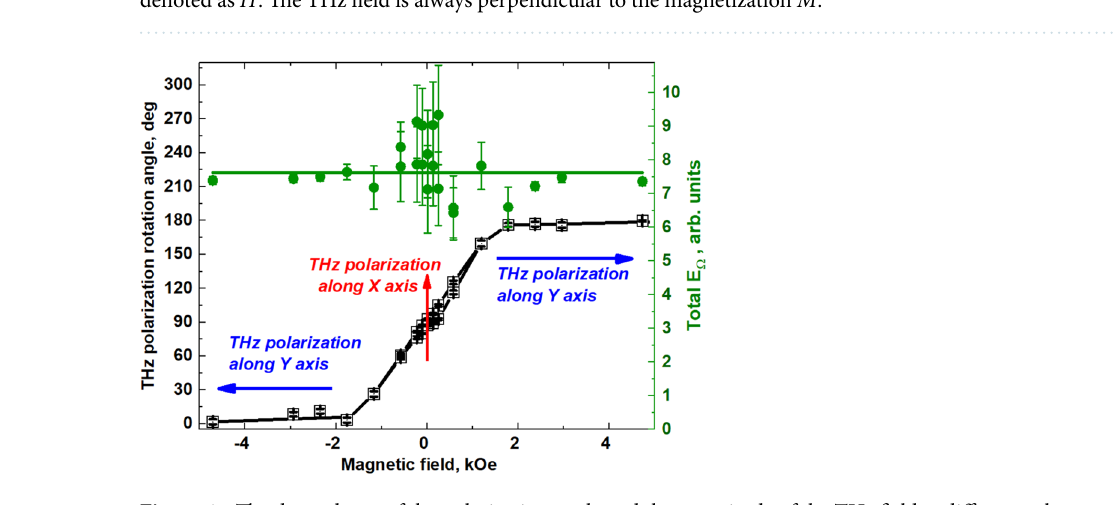
Figure 4. The dependence of the polarization angle and the magnitude of the THz field at different values of the magnetic field. Left scale: Magnetic field dependence of the THz polarization angle obtained from the fits of angular diagrams (Fig. 3) in the “hard axis” geometry. Right scale: total THz field dependence as fitting parameters from Eq. (S4) from Supporting Information file. Lines are guides for